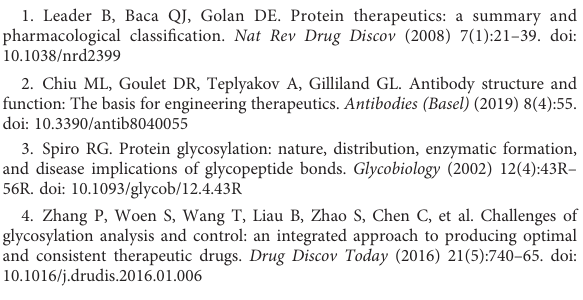
SUPPLEMENTARY FIGURE 5 Characterization of transglycosylated 15 N-NISTmAb-Fc with homogeneous glycoforms. Reducing SDS-PAGE gels show the shift in band migration of transglycosylated isotopically 15 N-NISTmAb-Fc (with G0, G1(3), G1(6), or G2) compared to starting material comprising only a single GlcNAc residue on each monomer. Lanes showing two bands contain both starting material and the transglycosylated Fc product to ensure these are two discreet bands. SUPPLEMENTARY FIGURE 6 Overlay of 2D 1 H- 15 N NMR spectra of EndoH-treated 15 N-Gn-NISTmAb- Fc (orange) and remodelled 15 N-G0-NISTmAb-Fc (red). SUPPLEMENTARY FIGURE 7 Overlay of 2D 1 H- 15 N NMR spectra of digalactosylated 15 N-G2-NISTmAb- Fc (blue) with (A) . monogalactosylated remodelled 15 N-G1(6)-NISTmAb- Fc (green), and (B) 15 N-G1(3)-NISTmAb-Fc (dark green). Peptide backbone amino acid residues that show chemical shift perturbations (CSPs)arelabelledandhighlightedwitharedbox,whileexamplesofother residues that show little to no CSPs are labelled as black text only without a red box. Compared to the digalactosylated protein, more chemical shift perturbations are observed with the monogalactosylation at the a 3 antenna (B) compared to the a 6 antenna (A) . SUPPLEMENTARY TABLE 1 1 H and 15 N chemical shifts (in ppm) and Combined Chemical Shift Difference (CCSD, in ppm) of amino acid residues that show Chemical Shift Perturbations (CSPs) between agalactosylated afucosylated Fc glycoform (G0) with glycoforms bearing a terminal galactose residue at the a 6 antenna. Low CCSD values are observed amongst afucosylated glycoforms with a terminal galactose residue at the a 6 antenna (i.e. G1(6) vs G2). D312 is used as a reference for a residue that showed low CCSD in all